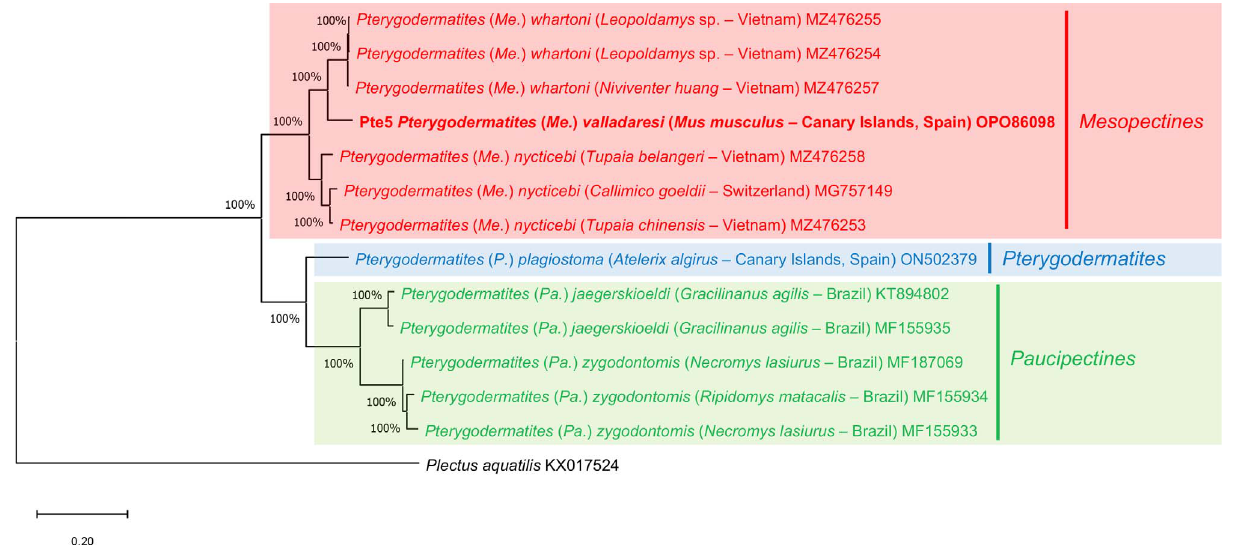
Figure 2. Phylogenetic analysis using the Maximum Likelihood method with p-distance and 1,000 bootstrap replications based on the MT- CO1 gene sequences exploring the relationships among Pterygodermatites species including the nucleotide sequences of P. ( Me. ) valladaresi n. sp. obtained in this study (shown in bold). Plectus aquatilis was used as the